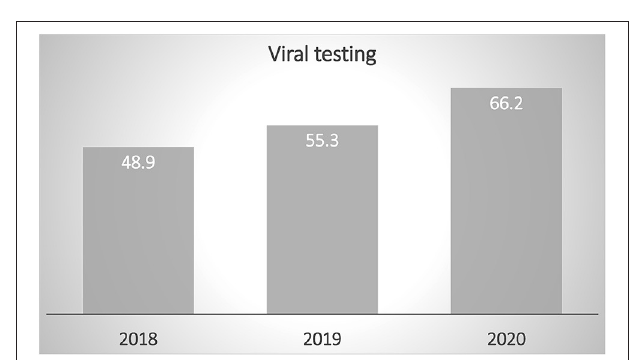
FIGURE 2 | Viral testing increased during the study months of 2020, reflecting increased measures to detect viral illnesses in early phase during the early phase of the coronavirus disease